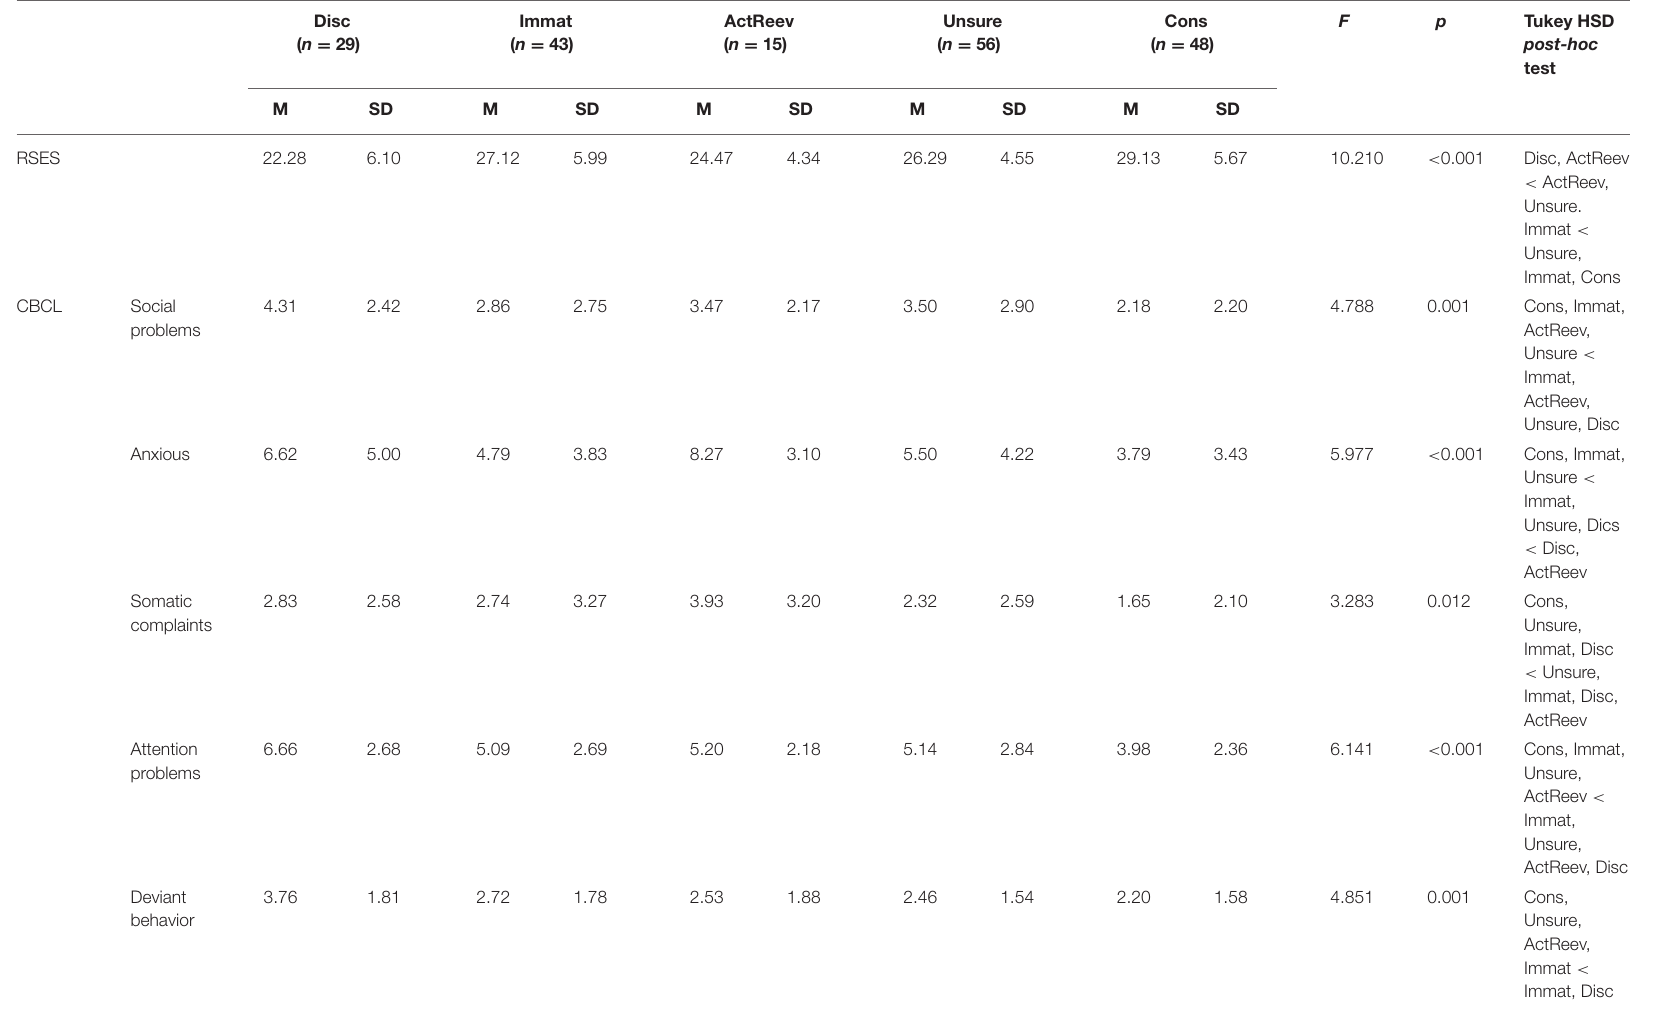
TABLE 7 | Comparison of the five H-UMICS (educational identity) clusters on the measured variables; results of